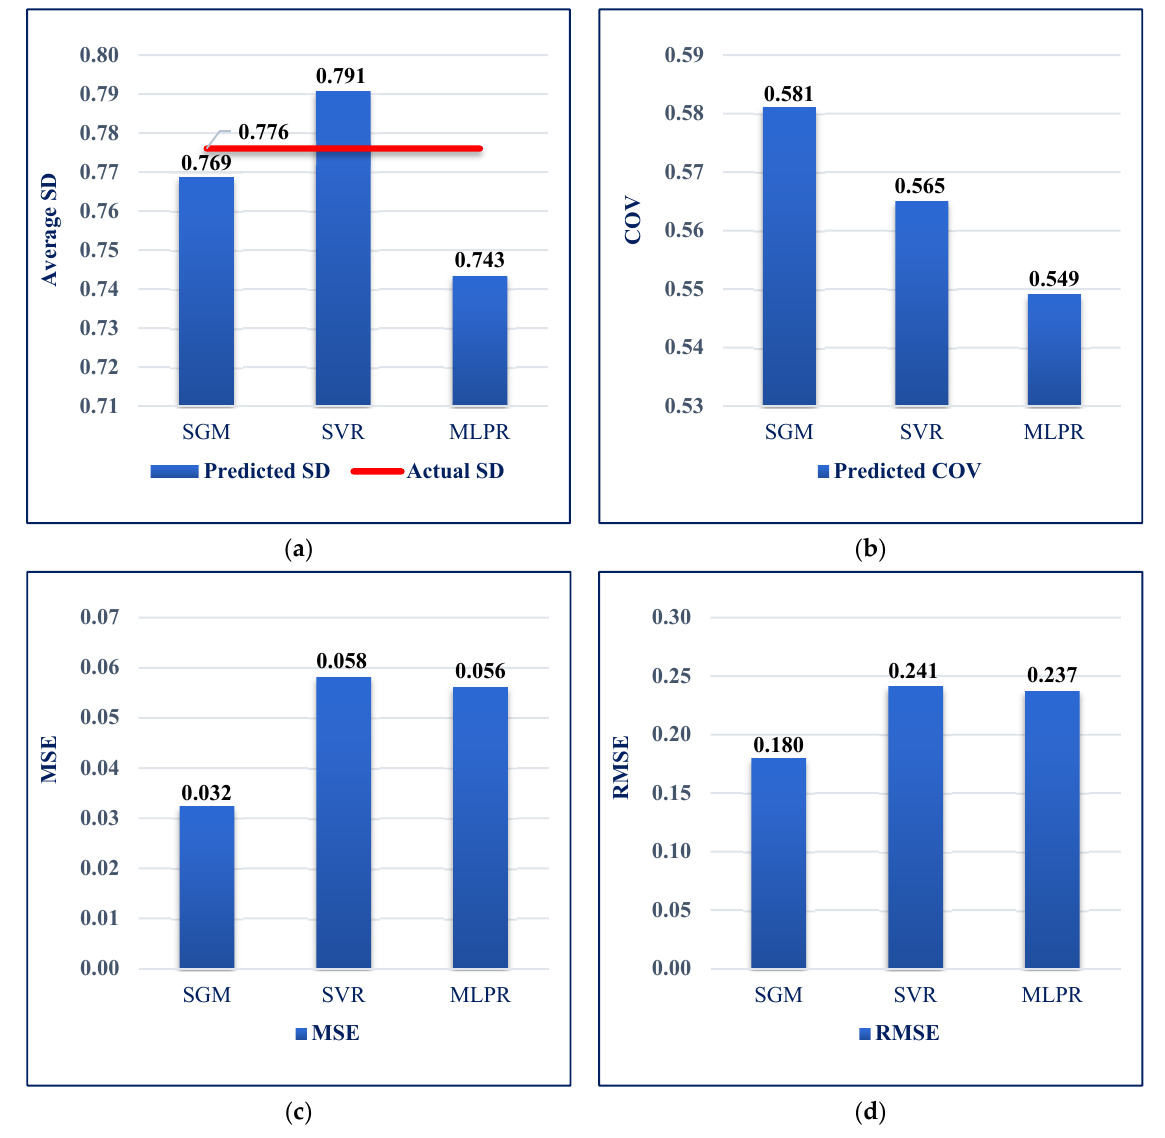
Figure 10. Overall performance comparison of machine learning models. ( a ) Standard deviation comparison; ( b ) covariance comparison; ( c ) mean-square error comparison; ( d ) Root-MSE comparison.